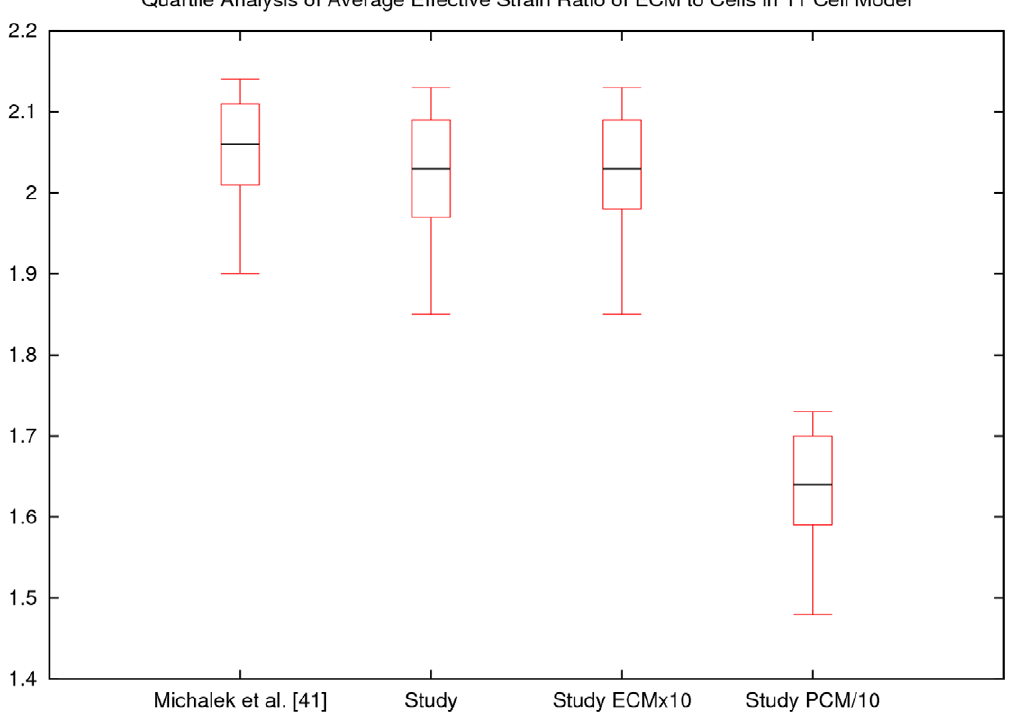
Figure 8. The quartile analyses of the ratios of average cellular effective strain to extracellular matrix (ECM) effective strain for the four cases considered in the material sensitivity study of the 11 cell model are shown above. In agreement with [41], scaling of material properties while maintaining ratio (Study and Study 6 10) does not strongly impact chondrocyte deformation, but modifying the stiffness ratio between micro-scale components, i.e. by decreasing pericellular matrix stiffness by tenfold (Study PCM/10),